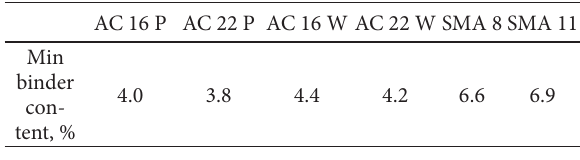
Table 3. HMA mixtures gradation and asphalt